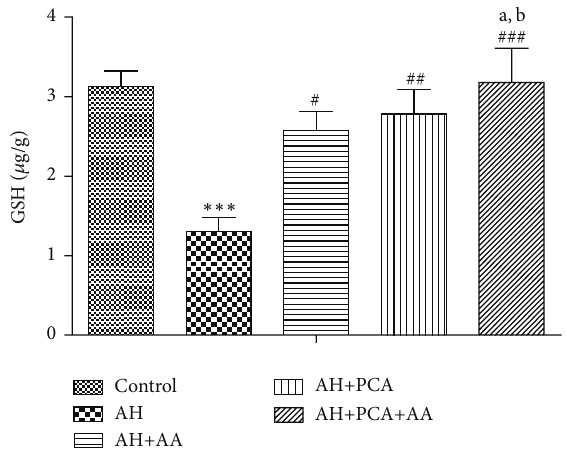
Figure 5: Effect of PCA alone and in combination with AA on reduced glutathione in AH-treated rats. Values are expressed as mean ± SEM. Level of significance is considered as ∗ 𝑝 < 0.05 , ∗∗ 𝑝 < 0.01 , and ∗∗∗ 𝑝 < 0.001 compared to control group. # 𝑝 < 0.05 , ## 𝑝 < 0.01 , and ### 𝑝 < 0.001 compared to AH-treated group. a 𝑝 < 0.05 compared to AH+PCA and b 𝑝 < 0.05 compared to AH+AA group.